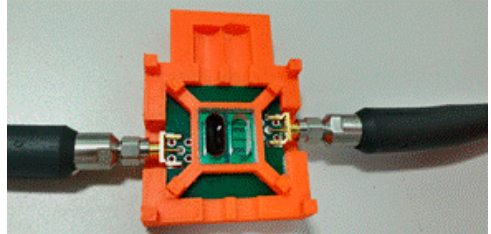
Figure 2. Close look at the developed electromagnetic wave sensor for early cancer detection. Two-port arrangement allows for both S 11 and S 21 simultaneous